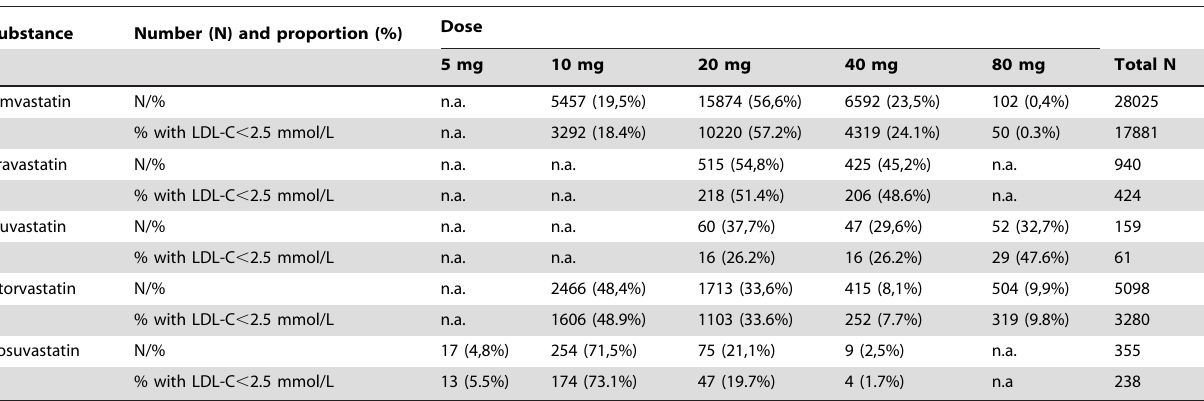
Table 2. Distribution of mean doses of the statins in patients on statins.